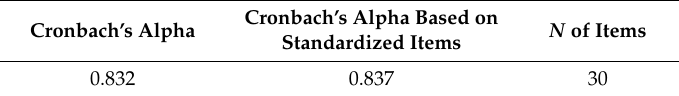
Table 5. Showing reliability statistics.